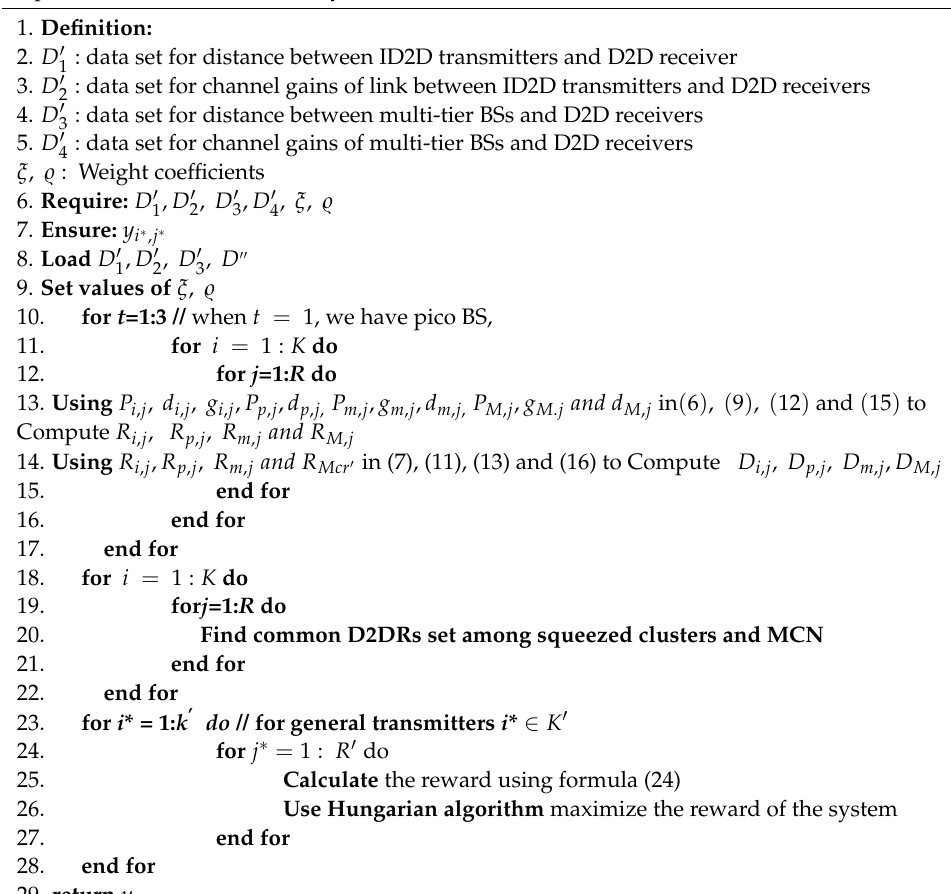
Algorithm 2. Hungarian Algorithm to Perform Content Delivery Decision Making and Optimizaion of Reward of the